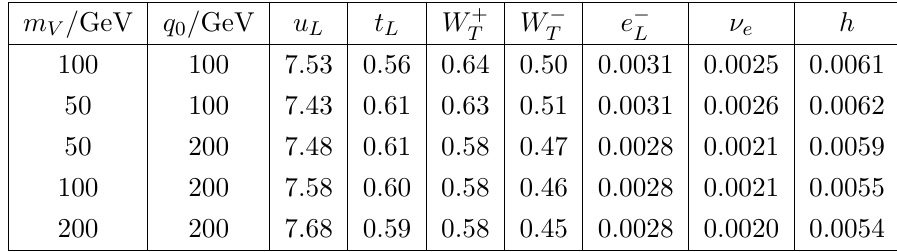
Table 3 . Momentum fractions (%) carried by various parton species at scale q = 100